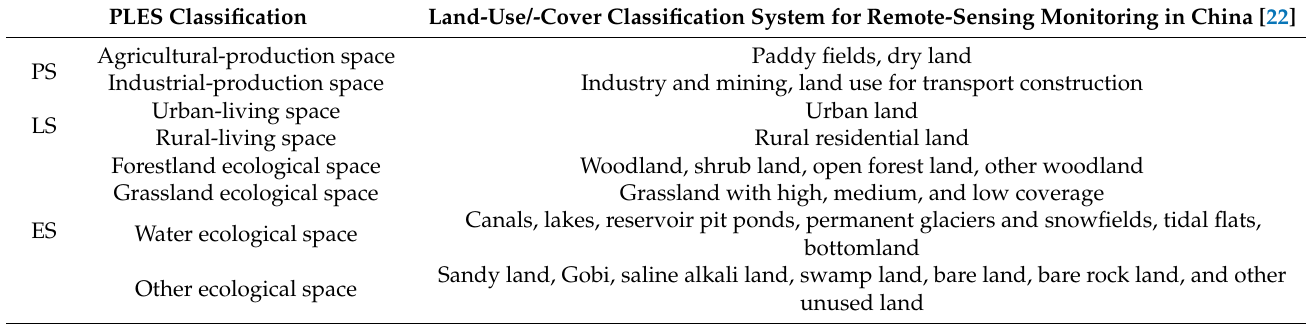
Table 1. Corresponding table of type between production–living–ecological space (PLES) and land use. PLES Classification